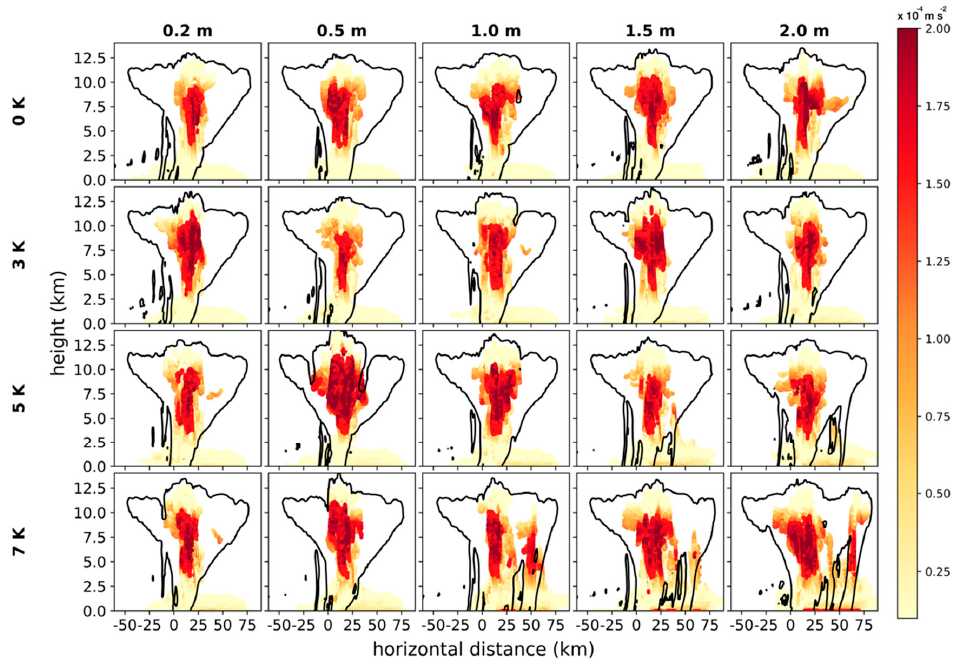
Figure 11. Same as Figure 10, except at t = 165 min. Further insights into the temporal evolution of updraft accelerations can be gained by analyzing contoured frequency by altitude diagrams (CFADs; Yuter and Houze [38]) of B. Figure 12 shows CFADs of maximum B along parcel trajectories for all simulations at t = 120 min. At this time, CFADs of B are very similar. In all simulations, most parcels achieve maximum buoyancy below 8 km and all parcels − 4 − 2 achieve a maximum B less than 2.5 × 10 m s